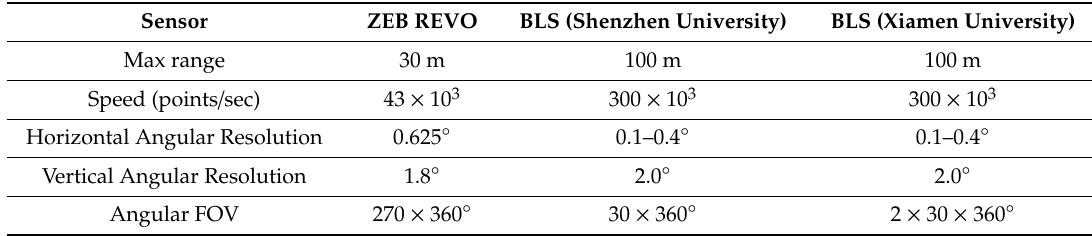
Figure 16. The experiment data. ( a ) Benchmark point clouds and trajectories acquired by handheld laser scanning (HLS), ZEB-REVO. ( b ) Point clouds acquired by Shenzhen University (BLS) system of Shenzhen University. ( c ) A closed-loop corridor by BLS system of Xiamen University. ( d ) Parking lot by BLS system of Xiamen University. Table 1. Technical specifications of the laser scanning